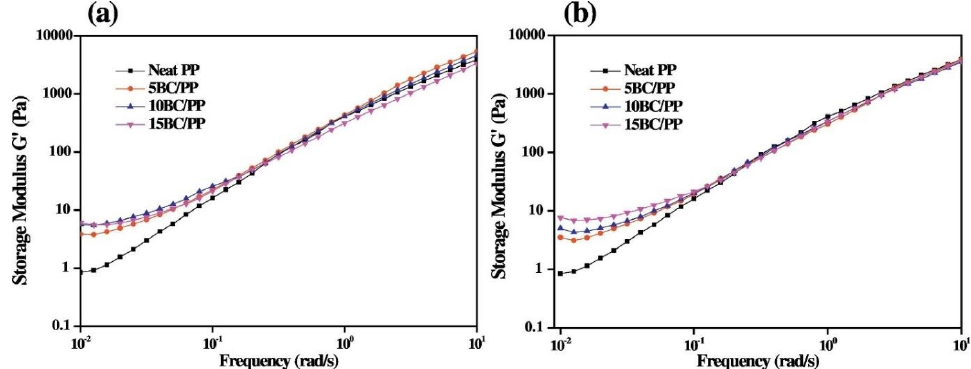
Figure 2. Storage modulus as a function of frequency for PP-based composites containing BC particles obtained at: ( a ) 700 °C and ( b ) 900 °C [52]. Reproduced with permission from Elsevier Science Ltd. 2018, Elsevier Science Ltd.